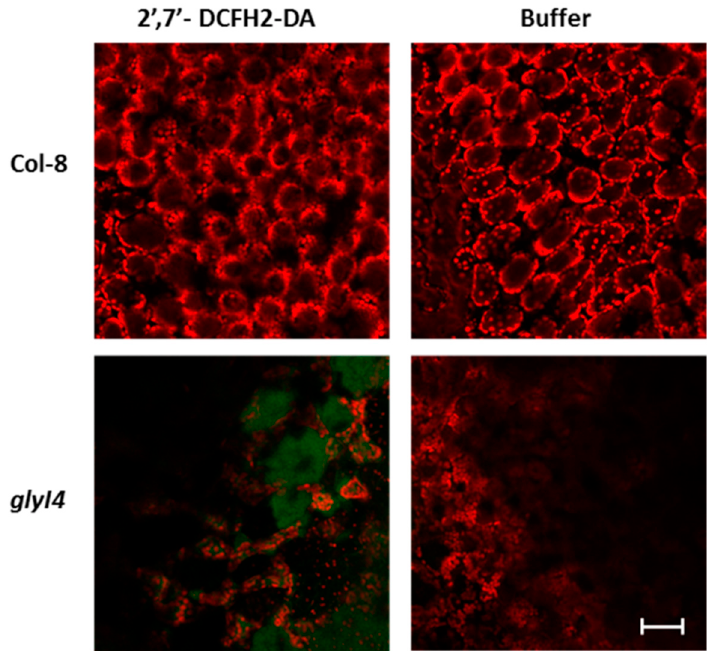
Figure 5. Detection of ROS in Arabidopsis Col-8 and glyI4 leaves. Detection on Col-8 and glyI4 leaves was carried out by using 2 ′ ,7 ′ -DCFH 2 -DA or buffer (negative technical control). Fluorescence was observed under an LSM 710 confocal microscope with Plan Neofluar 20/1.30 objective. Two laser excitations lines were used [i.e., 488 for probe detection (green) and 561 nm for chlorophyll autofluorescence (red)]. Bar corresponds to 50 µm.